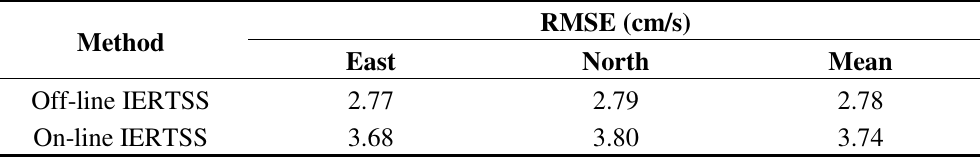
Table 9. Comparison of on-line and off-line mode in terms of velocity